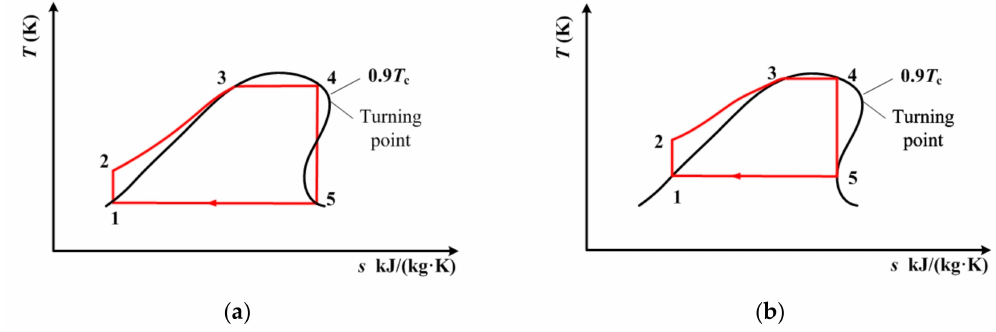
Figure 9. Transcritical ORC for cis-butene with single-screw expander when the condensation temperature is known: ( a ) 290 K, ( b ) 320 K.